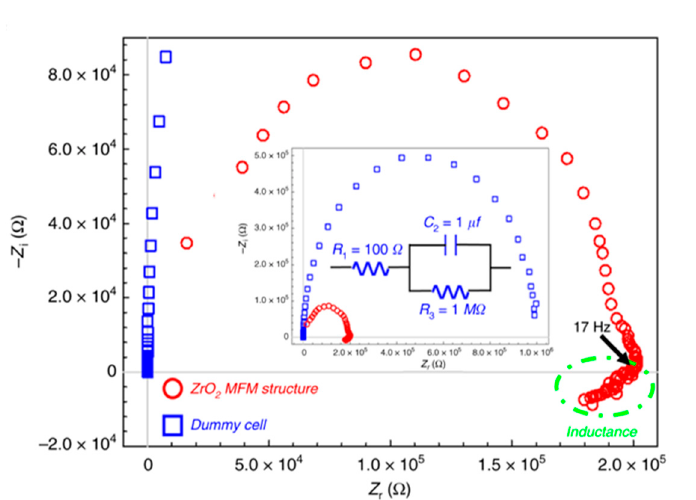
Figure 11. Nyquist plot based on the real and imaginary parts at the complex impedance (Zr + jZi) of MFM capacitor stacked with Pt–ZrO2–Pt. Resistor-capacitor (RC) dummy cell provided by Metrohm AUTOLAB, KM Utrecht, Netherlands is exhibited in an insert with RC component 100 Ω and an RC element (1 μ F) capacitance with 1 M Ω resistance integrated in parallel. Reprinted with permission from Ref. [52]. Copyright 2019. The authors are under Creative Commons License 4.0 (https://creativecommons.org/licenses/by/4.0/).